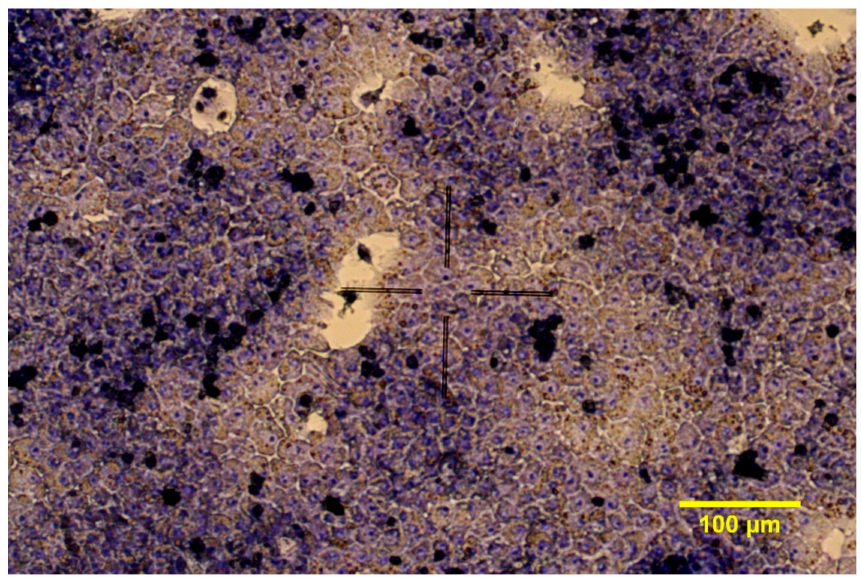
Figure 1. Giemsa staining of chicken hepatocyte—non-parenchymal cell co-cultures in 2D conditions (200 ×